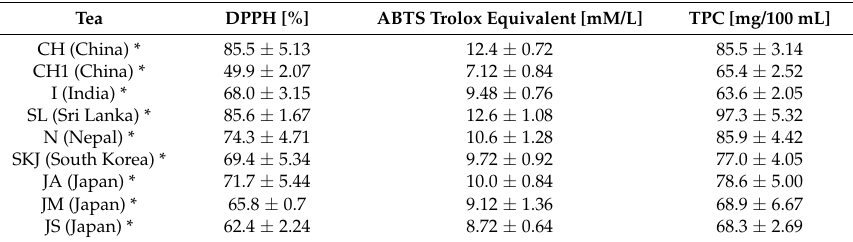
Table 7. Antioxidant activity and TPC of the investigated green